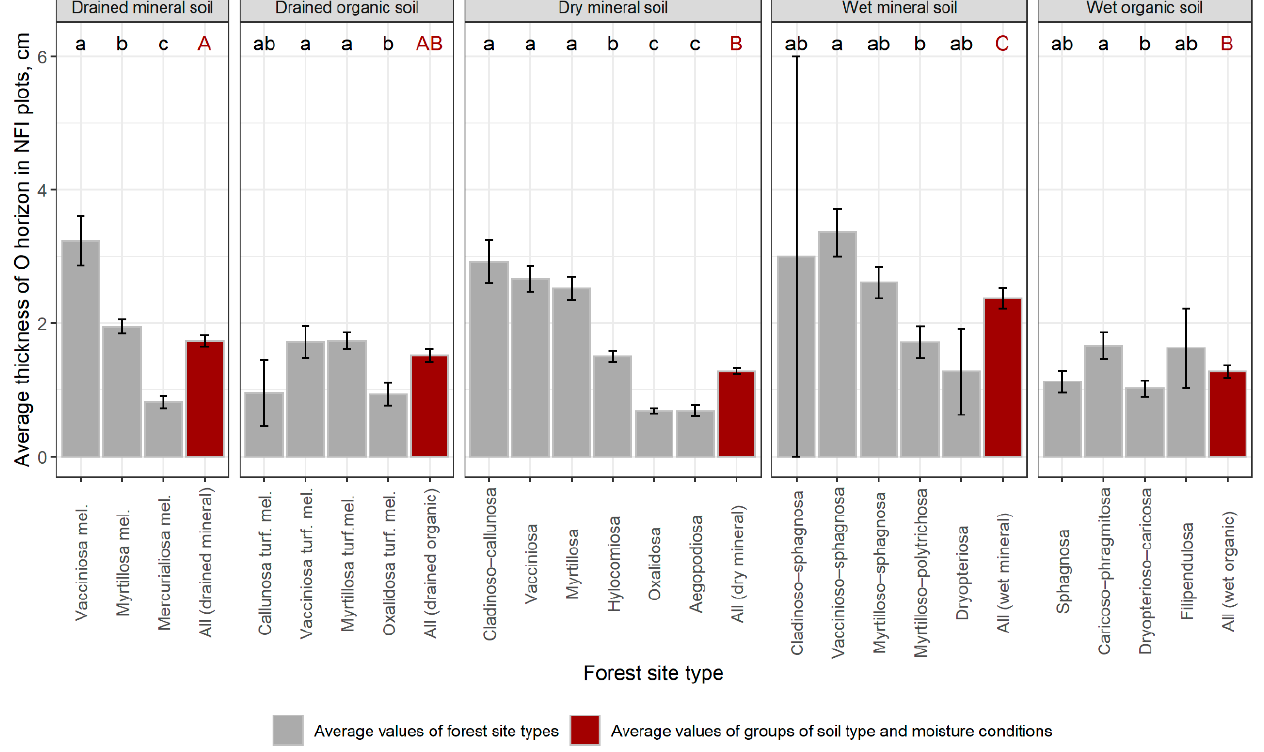
Figure 1. Average thickness of the O horizon in forest land in Latvia by forest site types. The division into groups based on soil types and moisture conditions is based on forest site types according to the national forest classification. Error bars represent standard errors. Different lower-case letters (black) show statistically significant differences ( p < 0.05, α = 0.05) in average values between forest site types within a group of soil type and moisture conditions; different upper-case letters (red) show statistically significant differences ( p < 0.05, α = 0.05) in average values between different groups of soil type and moisture conditions.